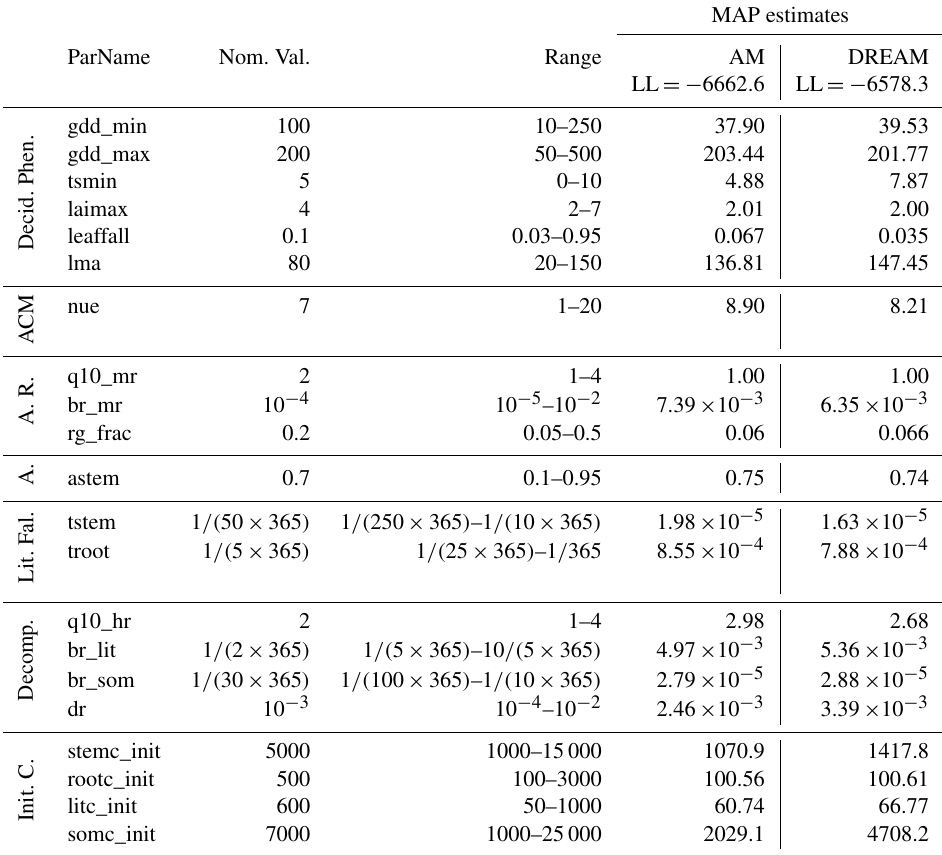
Table 1. Nominal values and ranges of the 21 parameters for optimization in the DALEC model, and the maximum a posteriori (MAP) estimates based on the AM and DREAM